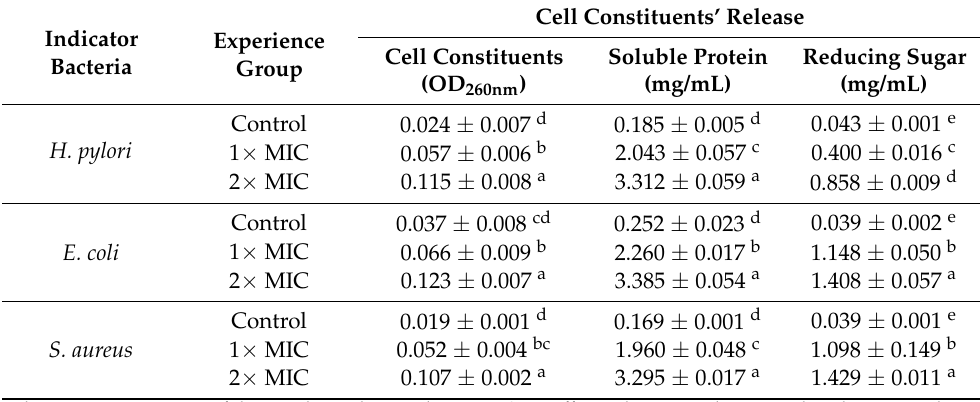
Table 4. Effects of EPS on cell components’ release of H. pylori